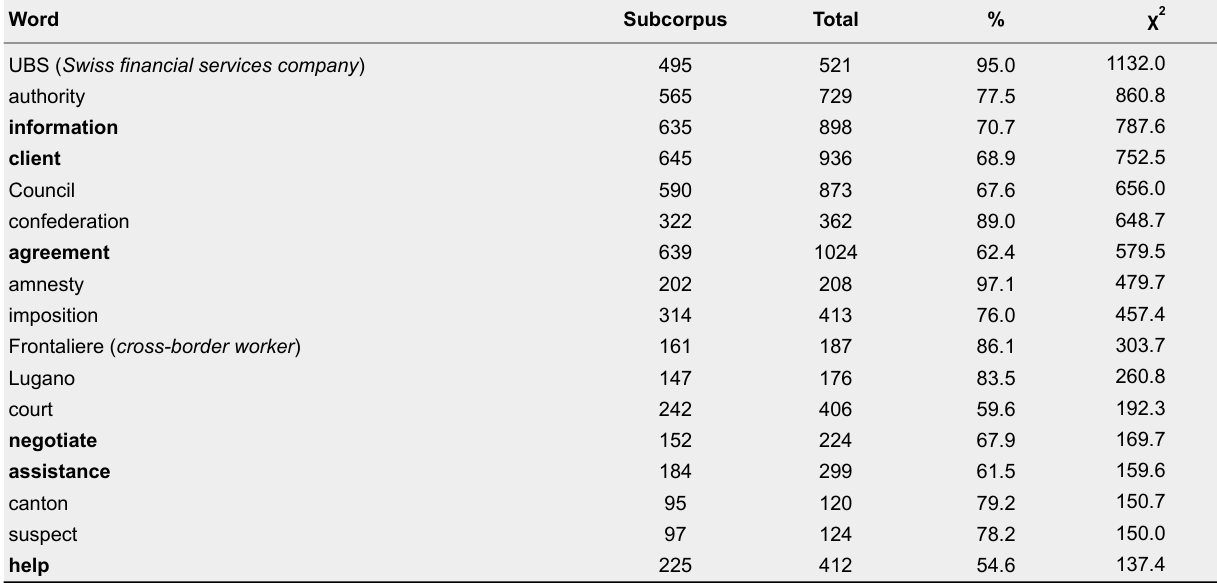
Specificity Analysis: Overused Words in Canton of Ticino